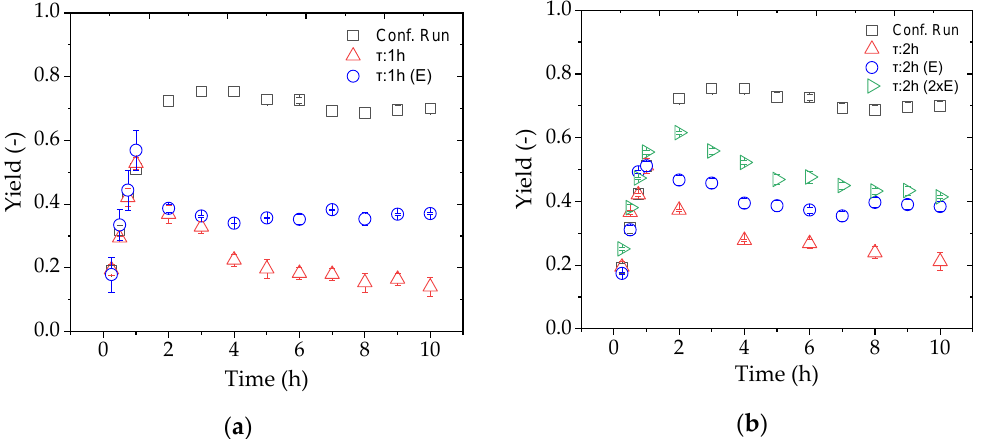
Figure 12. The yield of FOS during continuous production in an enzyme membrane reactor (EMR) after switching from total-recycle to continuous mode after 1 h with residence times of ( a ) 1 and ( b ) 2 h. Reactions were tested without enzyme replacement (red), with a single dose of replacement enzyme (blue), and with a double dose of replacement enzyme (green).